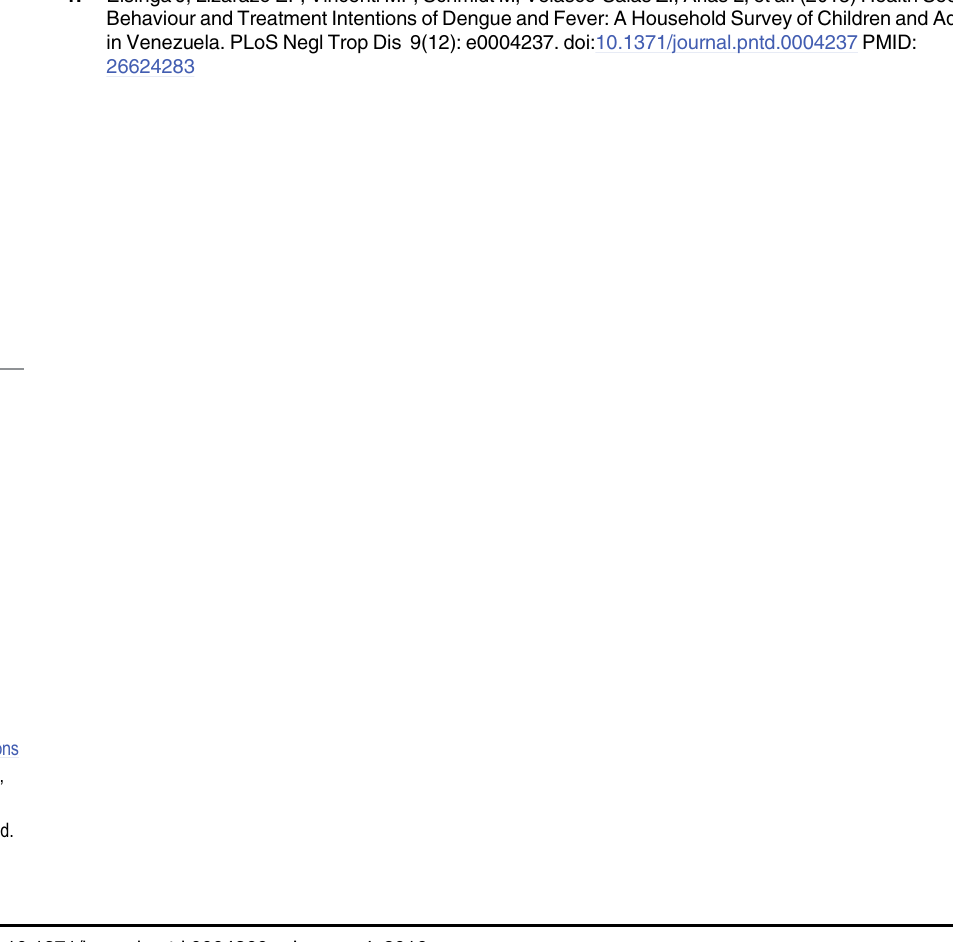
S3 Table. Supplementary dataset. This file includes supplementary